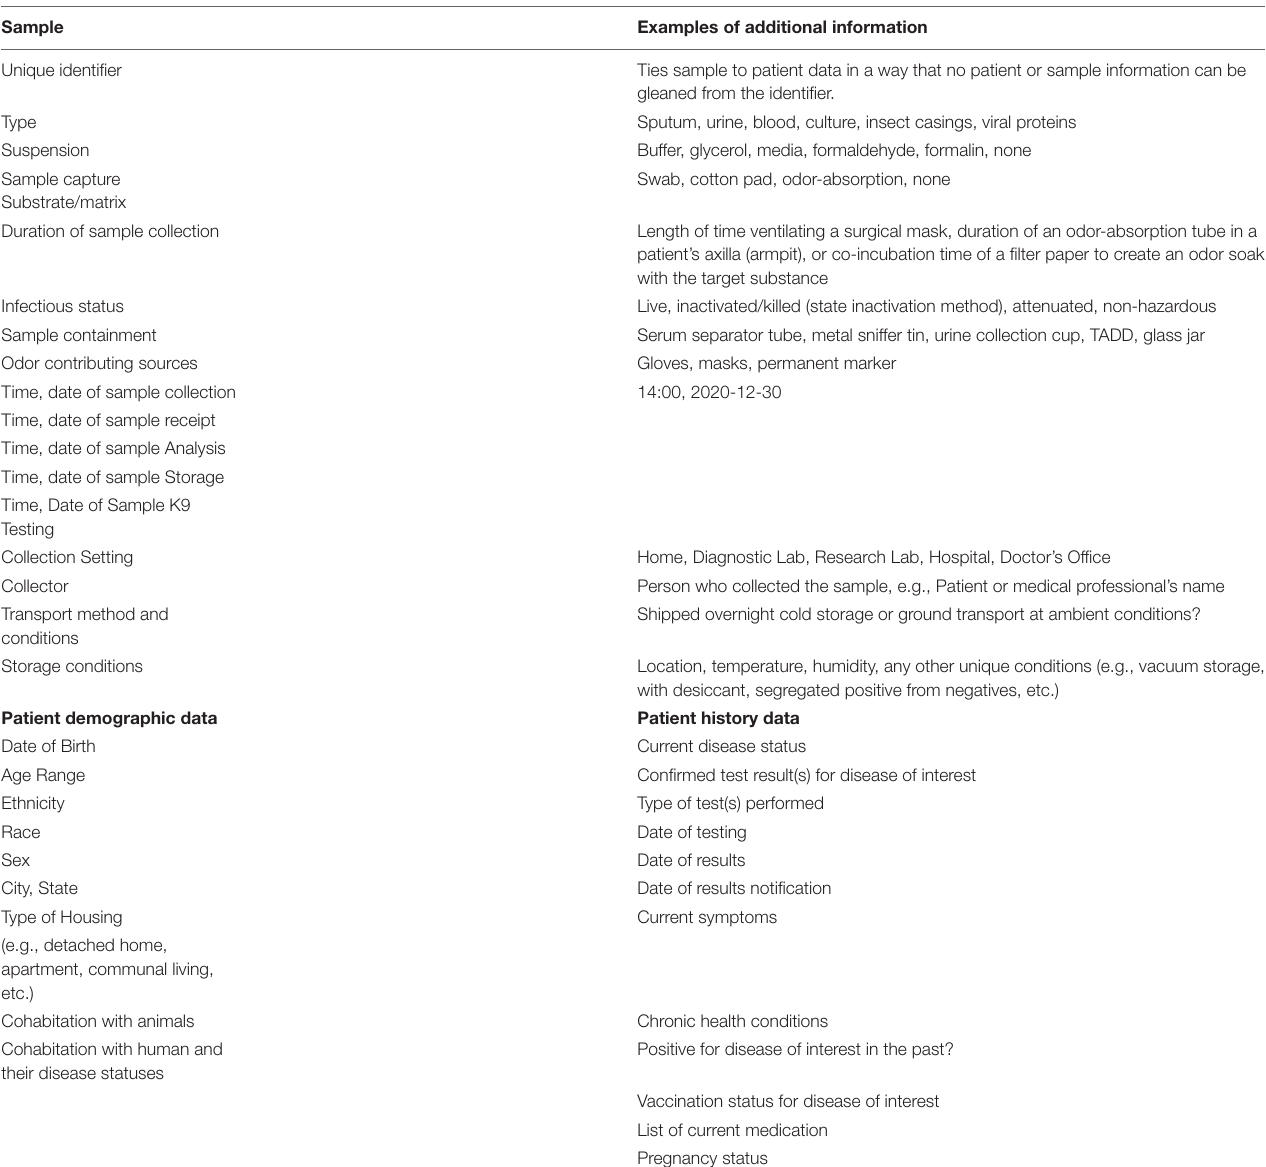
TABLE 4 | Minimum sample and patient information recommended for biomedical detection dog studies. Sample Examples of additional